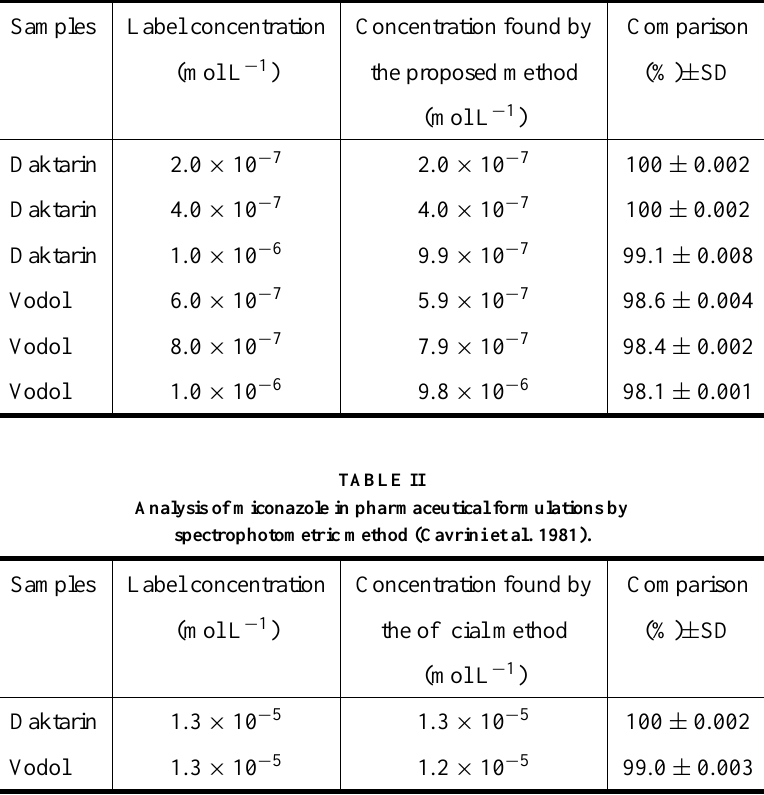
Analysis of miconazole in pharmaceutical formulations by voltammetric method.